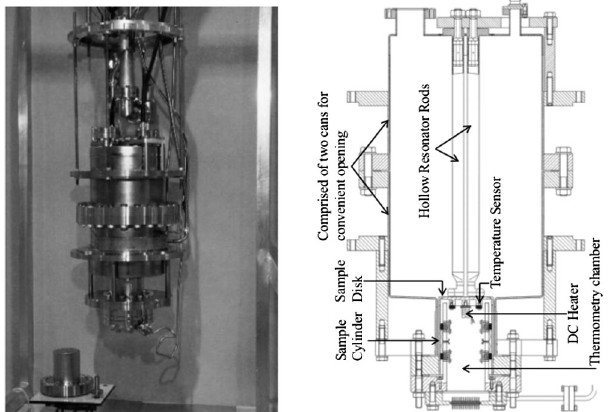
FIG. 2. According to the calorimetric method, the surface resistance of a superconducting sample is derived from a dc measurement